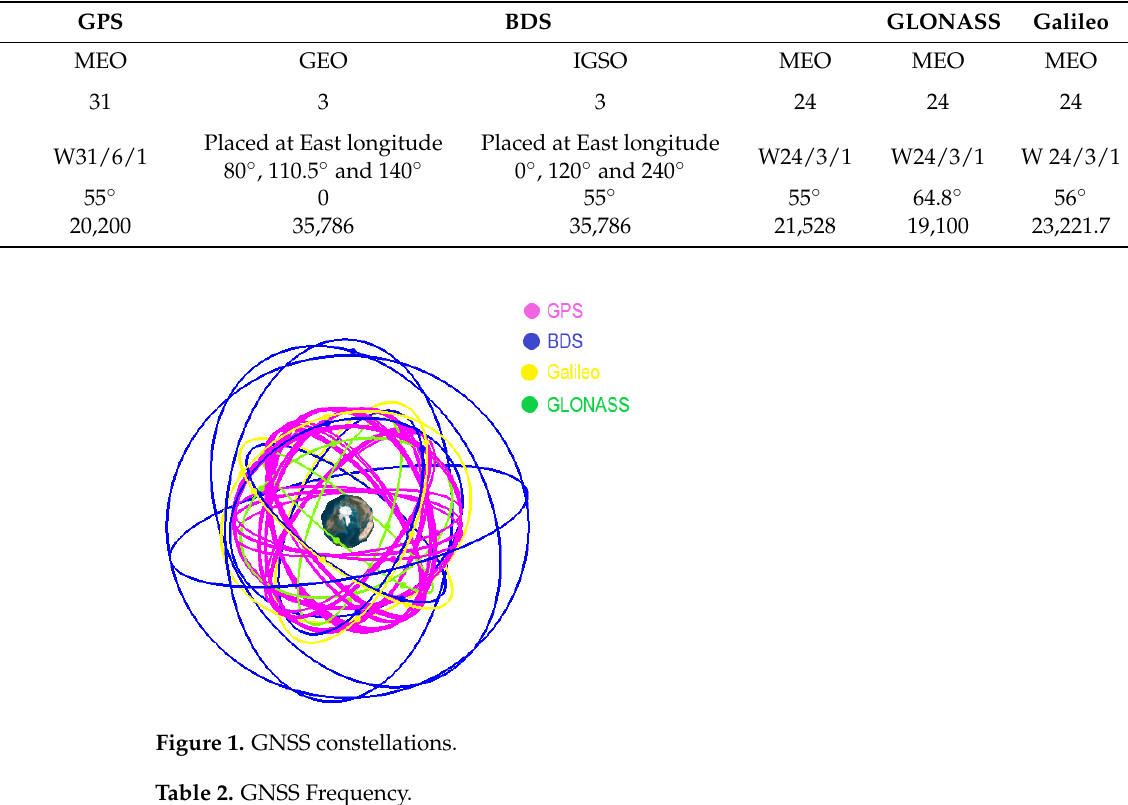
Table 1. Parameters of GNSS Constellations.